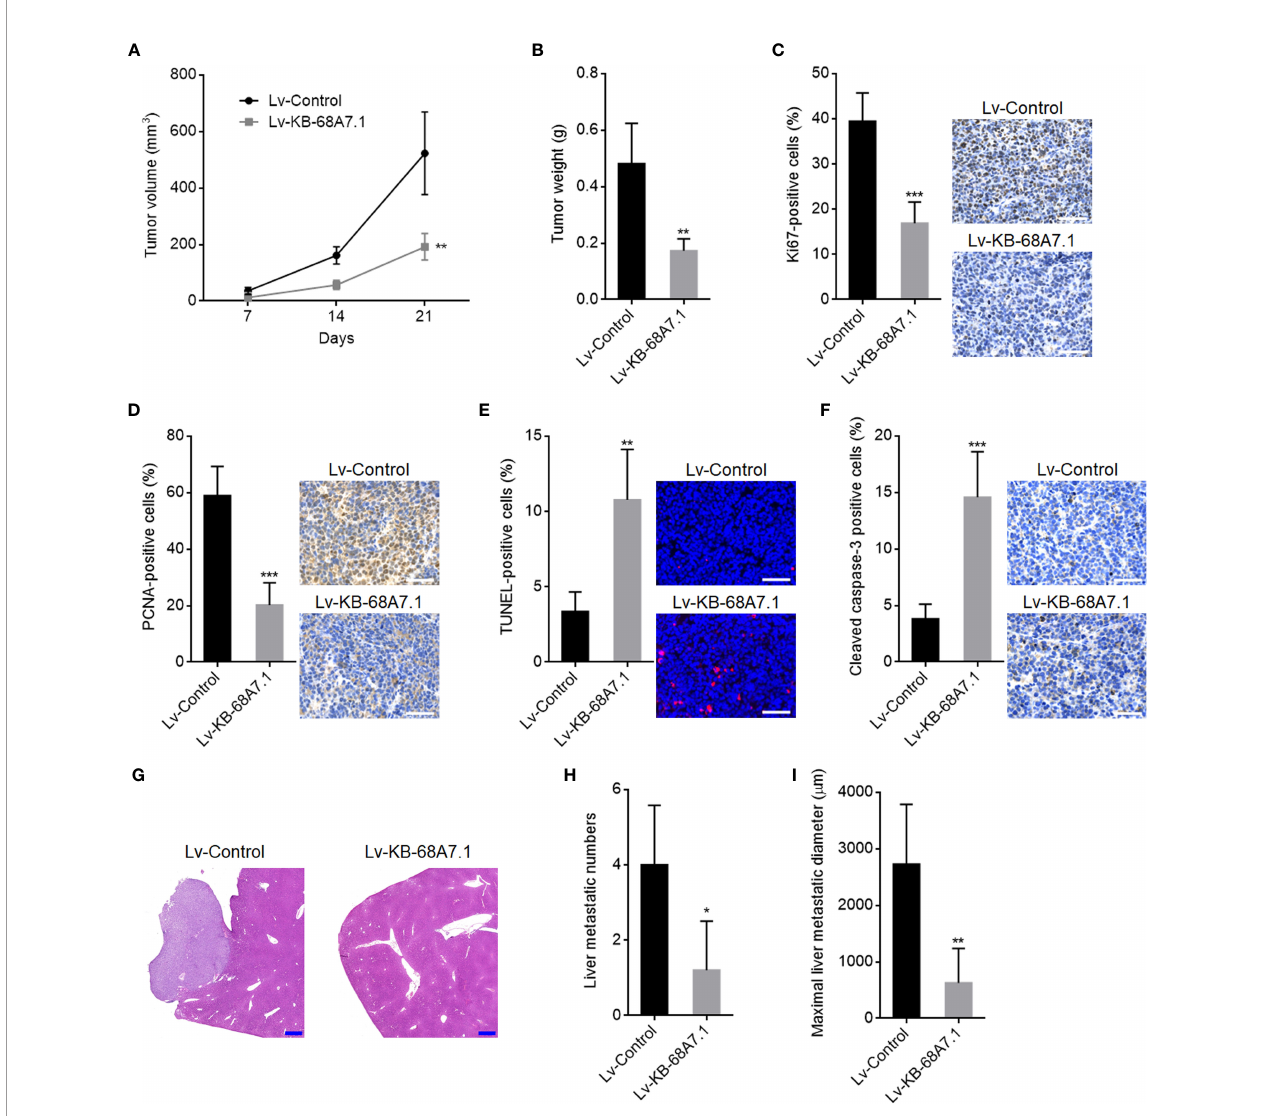
FIGURE 4 | The roles of KB-68A7.1 in HCC tumour growth and metastasis. (A, B) SNU-398 cells with KB-68A7.1 stable overexpression or control were subcutaneously injected into nude mice. Subcutaneous xenograft volumes were measured every 7 days (A) . Subcutaneous xenografts were resected and weighed at the 21st day after inoculation (B) . (C) Subcutaneous xenografts were subjected to Ki67 IHC staining. Scale bars = 50 µm. (D) Subcutaneous xenografts were subjected to PCNA IHC staining. Scale bars = 50 µm. (E) Subcutaneous xenografts were subjected to TUNEL assays. Scale bars = 50 µm. (F) Subcutaneous xenografts were subjected to cleaved caspase-3 IHC staining. Scale bars = 50 µm. (G – I) SNU-398 cells with KB-68A7.1 stable overexpression or control were intrasplenically injected into nude mice to construct liver metastasis model. At the 35th day after injection, the livers were resected and subjected to H&E staining. Scale bars = 500 µm (G) . The number (H) and size (I) of liver metastatic nodules were counted. Results are shown as mean ± SD based on n = 5 mice in each group. *p < 0.05, **p < 0.01, ***p < 0.001 by two-tailed unpaired